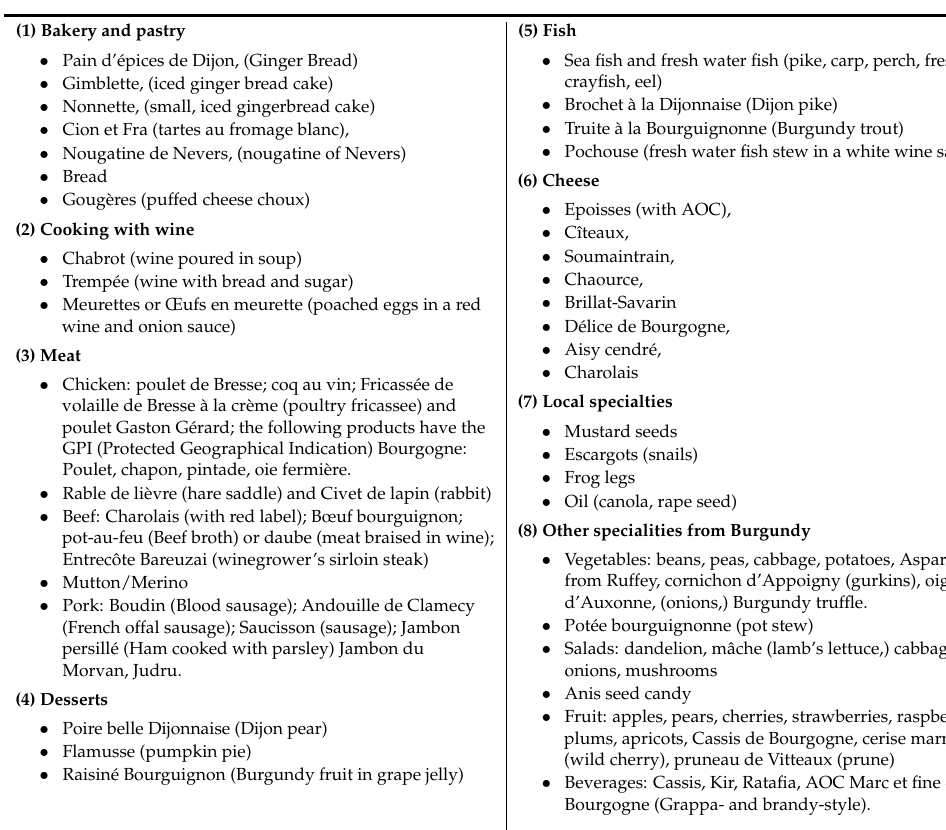
Table 3. Inventory of traditional food made in